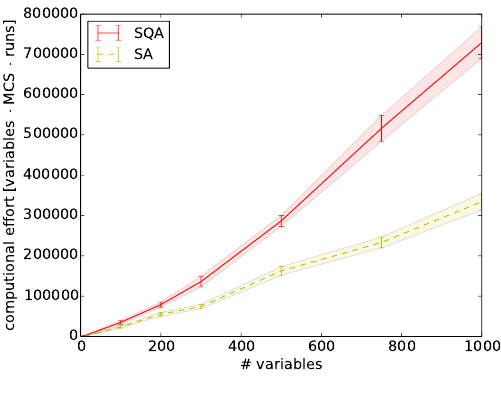
Figure 6: Average computational effort needed to find a solution to a random 4-SAT problem with 99%. The average is taken over 20 randomly generated 4-SAT instances with a clauses- ≈ to-variables-ratio of α χ 4